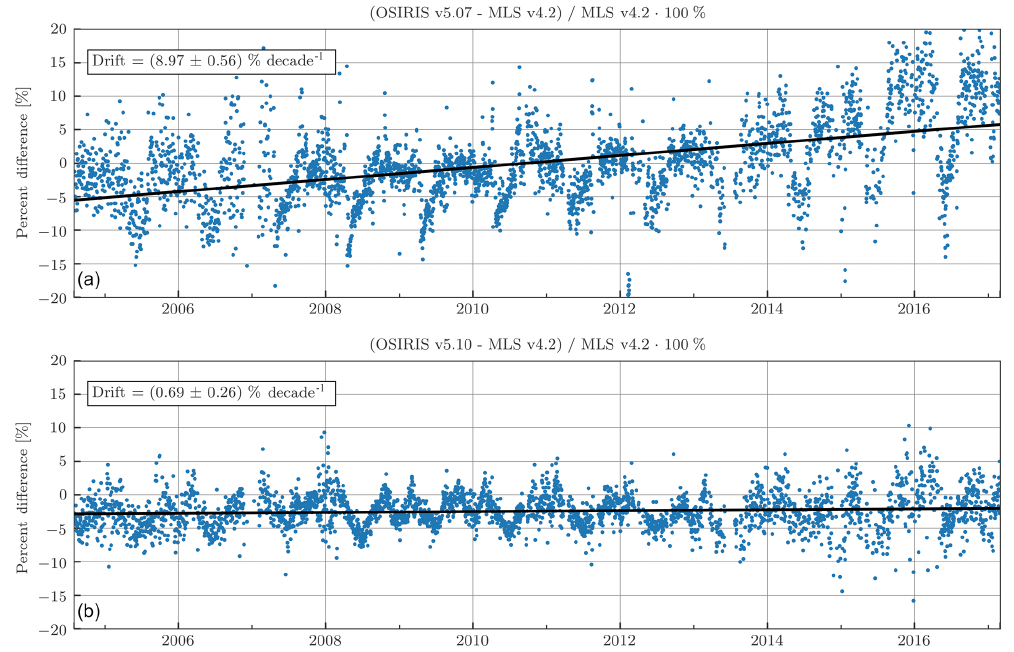
Figure 6. Daily averaged percent difference in zonal mean ozone from 10 ◦ S to 10 ◦ N at 40.5km relative to MLS v4.2 for OSIRIS v5.07 (a) and OSIRIS v5.10 (b) . The MLS v4.2 data are converted to number density on an altitude grid using ERA-Interim reanalysis pressure and temperature fields. Simple best-fit straight-line drift estimates are shown in black, with uncertainties reported as the 2 σ